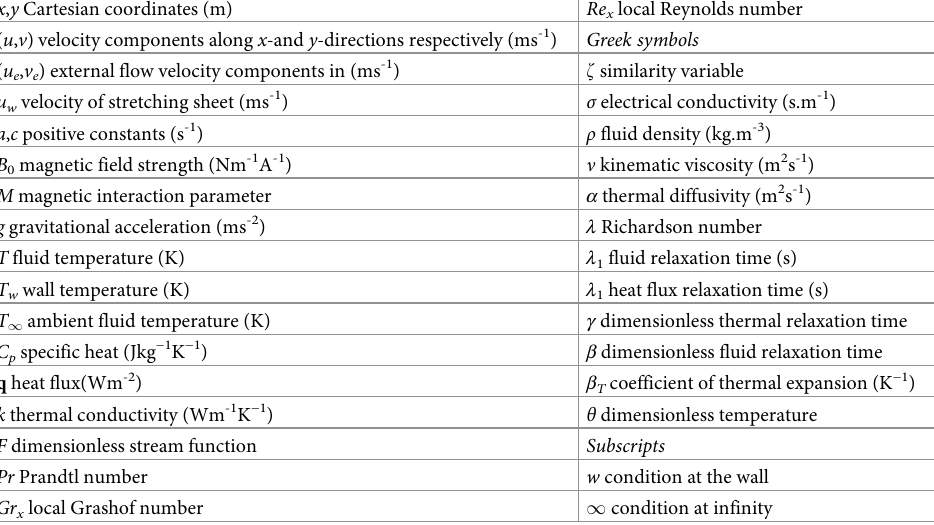
Table 1. List of